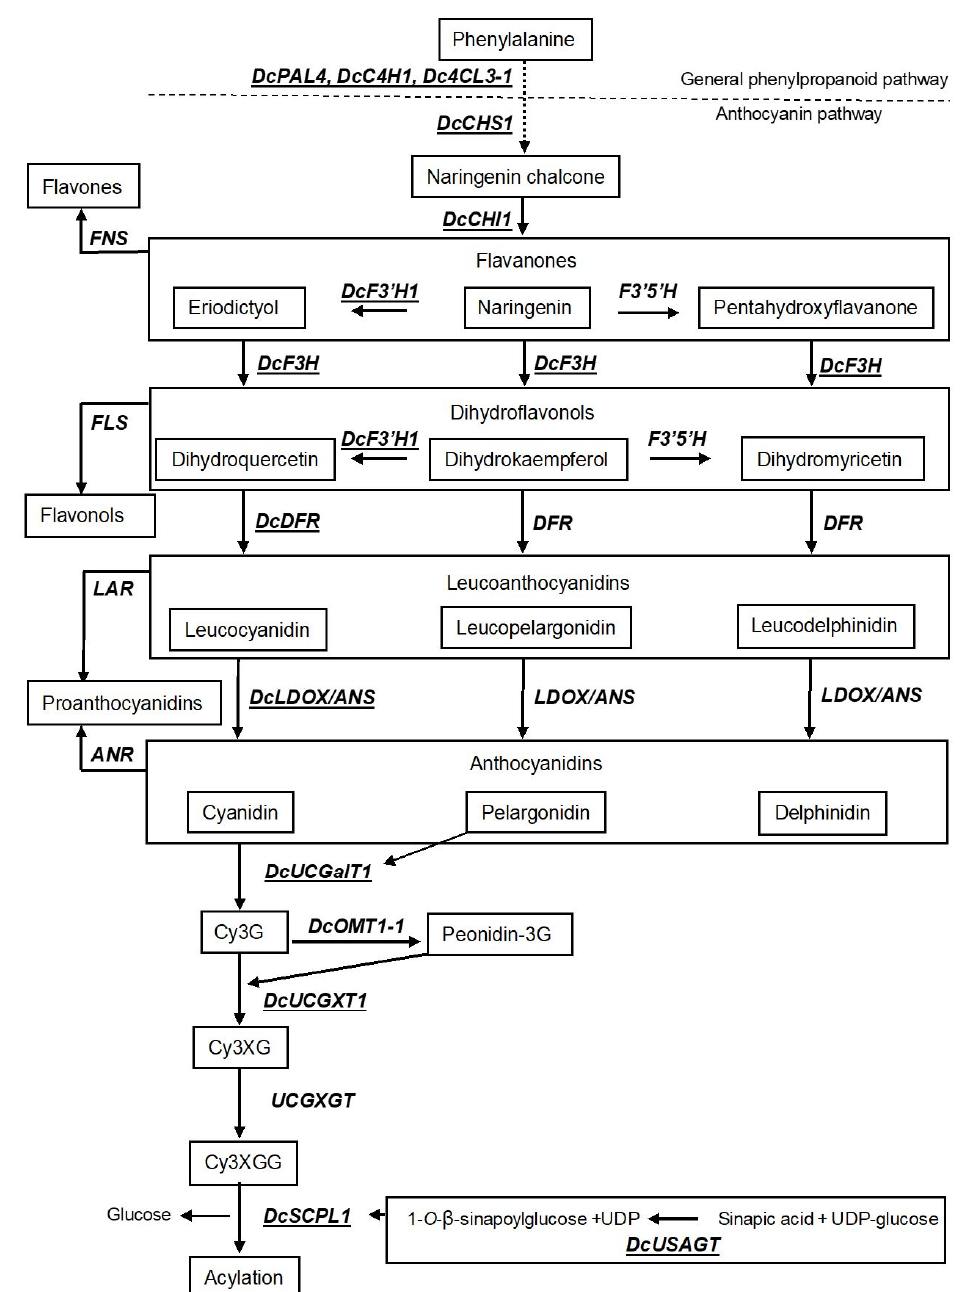
Figure 2. Simplified schematic diagram of the anthocyanin biosynthetic pathway. Structural enzymes are indicated in capital italic letters and intermediate compounds are represented in boxes. Enzymes underlined and with Dc prefix are upregulated in purple versus non-purple black carrot taproot tissue. PAL , phenylalanine ammonia lyase; C4H , cinnamate 4-hydroxylase; 4CL , 4-coumaroyl-coenzyme A ligase; CHS , chalcone synthase; CHI , chalcone isomerase; FNS , flavone synthase; F3H , flavanone 3-hydroxylase; FLS , flavonol synthase; F3 (cid:48) H , flavonoid 3 (cid:48) -hydroxylase; F3 (cid:48) 5 (cid:48) H , flavonoid 3 (cid:48) -5 (cid:48) -hydroxylase; DFR , dihydroflavonol 4-reductase; LAR , leucoanthocyanidin reductase; ANR , anthocyanidin reductase; LDOX/ANS , leu- coanthocyanidin dioxygenase/anthocyanidin synthase; UCGalT1 , UDP-galactose: cyanidin galactosyltransferase; OMT , O -methyl transferase; UCGXT1 , UDP-xylose:cyanidin 3-galactoside xylosyltransferase; UCGXGT1 , UDP-glucose:cyanidin 3-xylosylgalactoside glucosyltransferase; SCPL , serine carboxypeptidase-like; USAGT1 , UDP-glucose: sinapic acid gluco- syltransferase. Bold arrows indicate direct conversion. Dashed arrow indicates conversion through